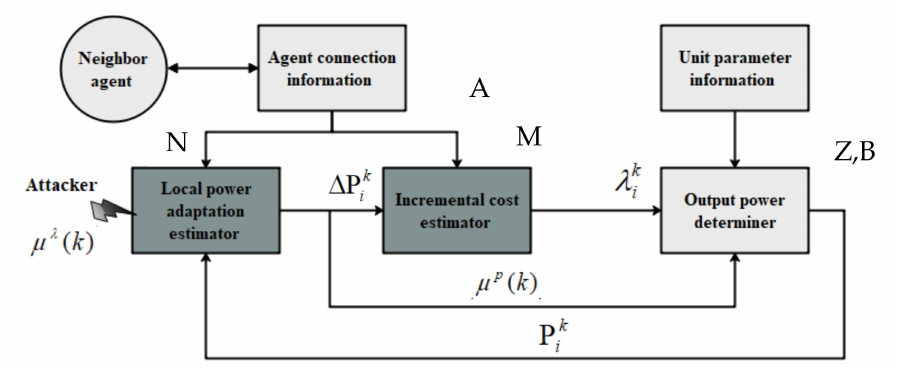
Figure 4. Energy management algorithm when there is a data integrity attack in a communication